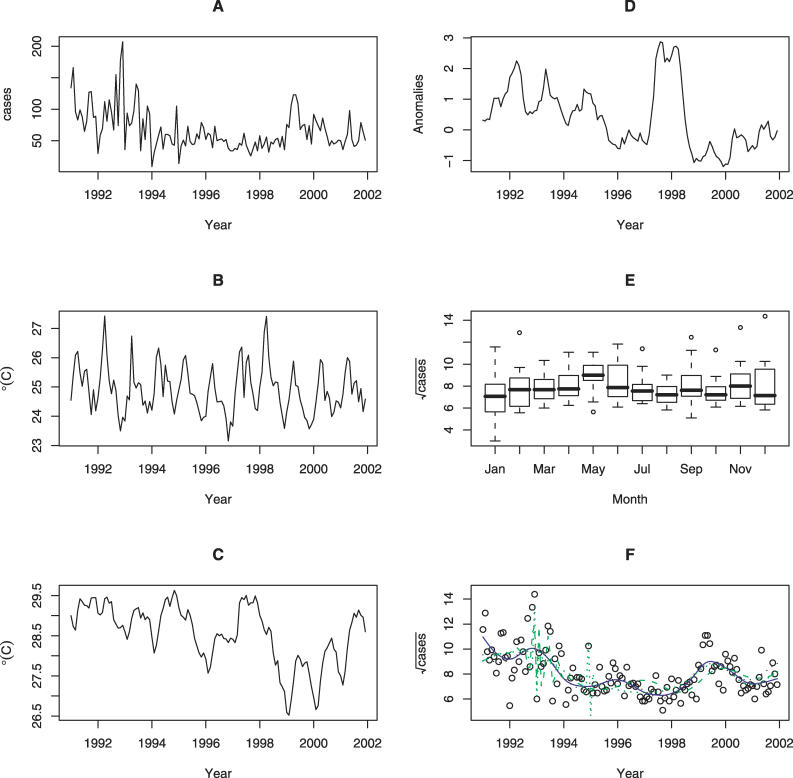
Time Series(A) CL cases in Costa Rica.(B) Mean temperature in Costa Rica.(C) SST 4.(D) MEI.(E) Box plot with monthly square-root-transformed CL cases.(F) The fits of (1) the Daubechies discrete wavelet (green lines), used to detrend the series so that the resulting data can then be analyzed for their dominant frequencies with a periodogram (a filter number 5 and eight levels of decomposition were used for this wavelet; the dashed line corresponds to periodic edges, and the dotted line to symmetric ones); (2) smoothing splines (blue solid line) and the first four reconstructed components of singular spectrum analysis (black dashed line; 60 orders). These methods were used to de-noise the signals so that dominant frequencies could be identified (with the maximum entropy spectral density method).